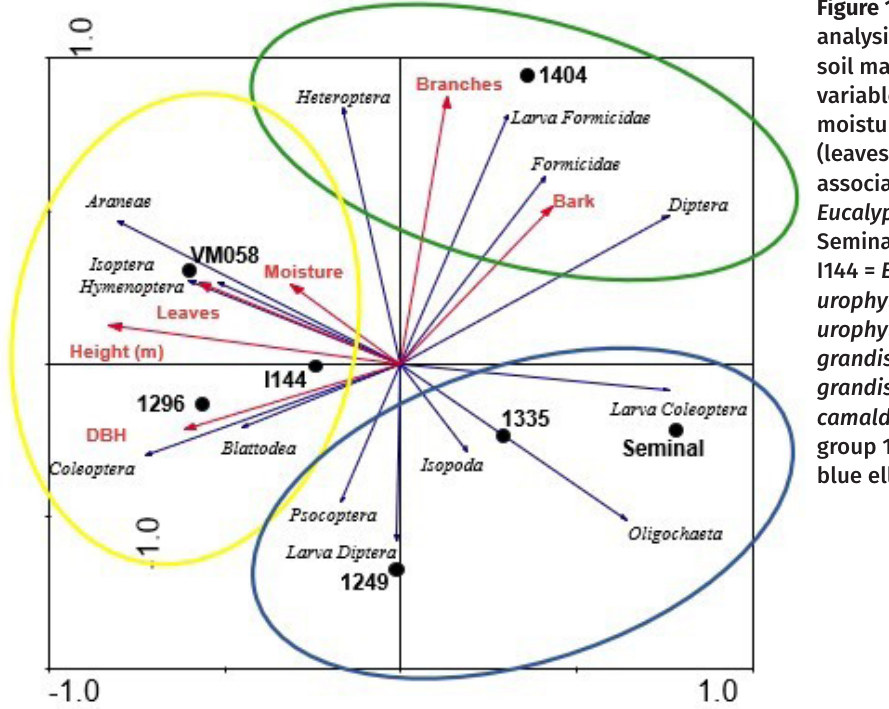
camaldulensis . Yellow ellipse